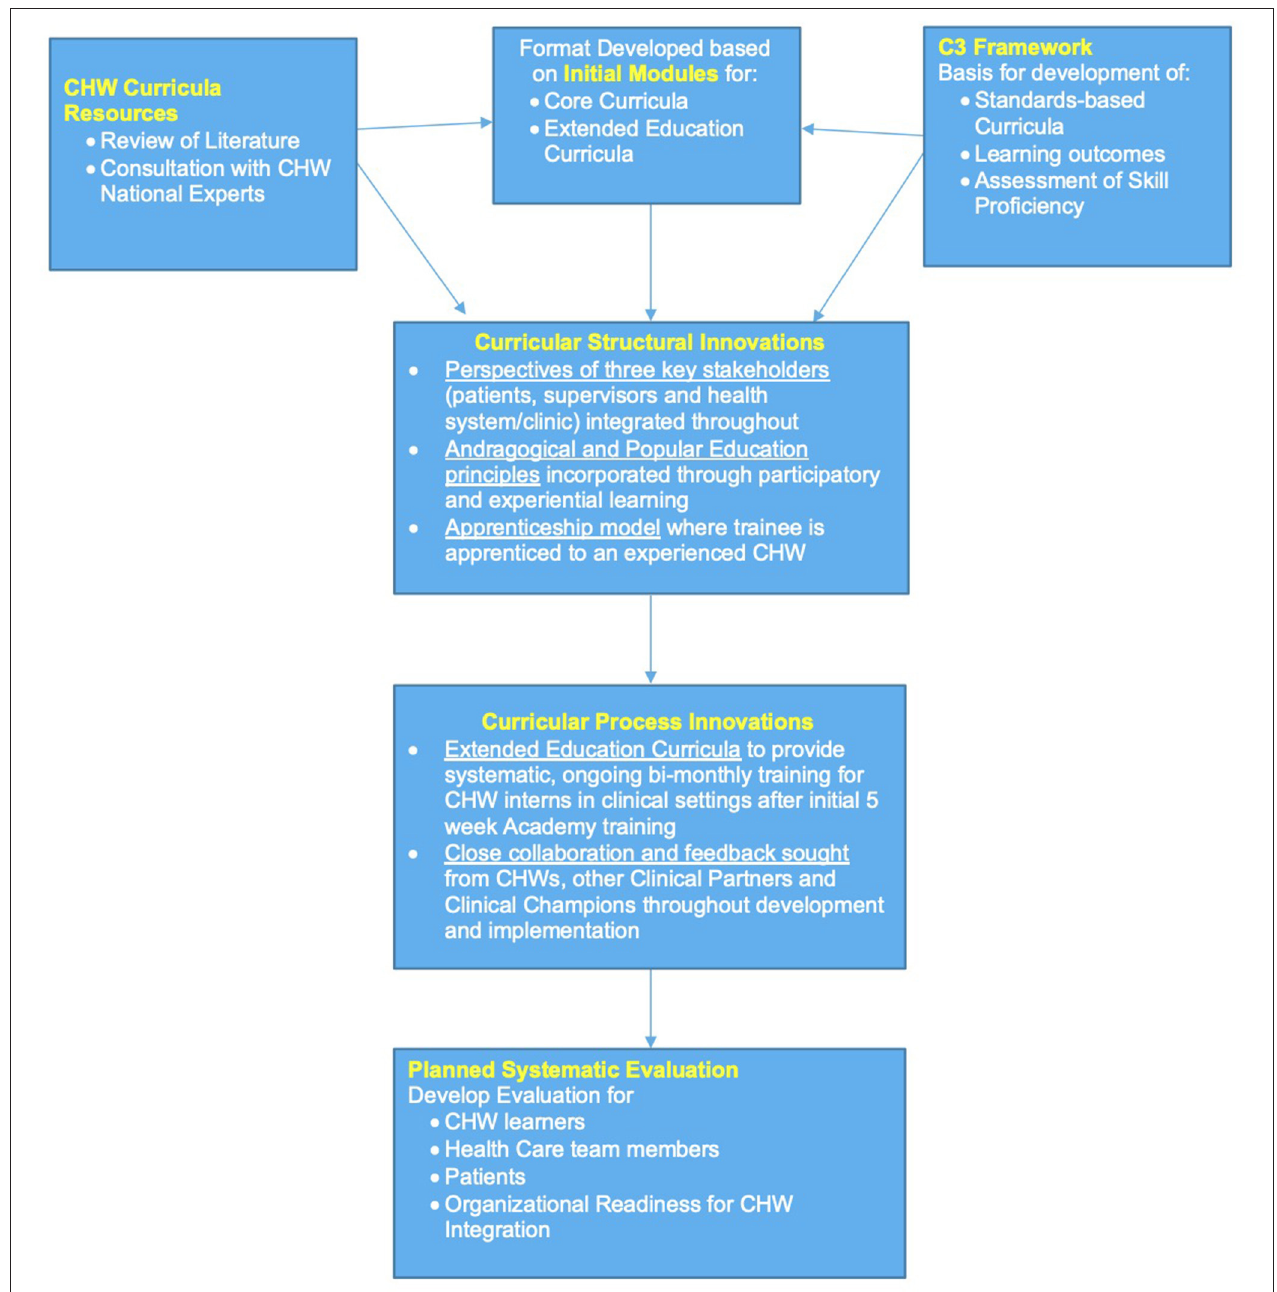
FIGURE 1 | CDU CHW academy curriculum development